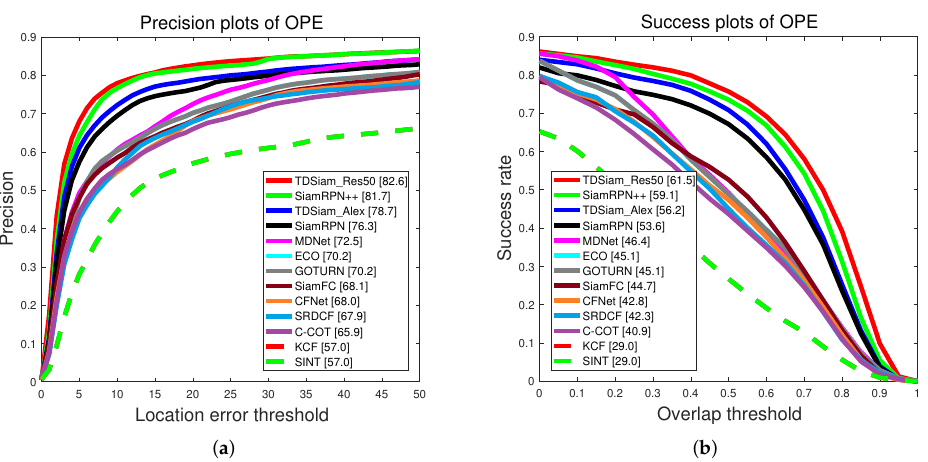
Figure 12. Experimental results of using different methods on the UAVDT dataset. ( a ) Precision plots; ( b ) Success plots.